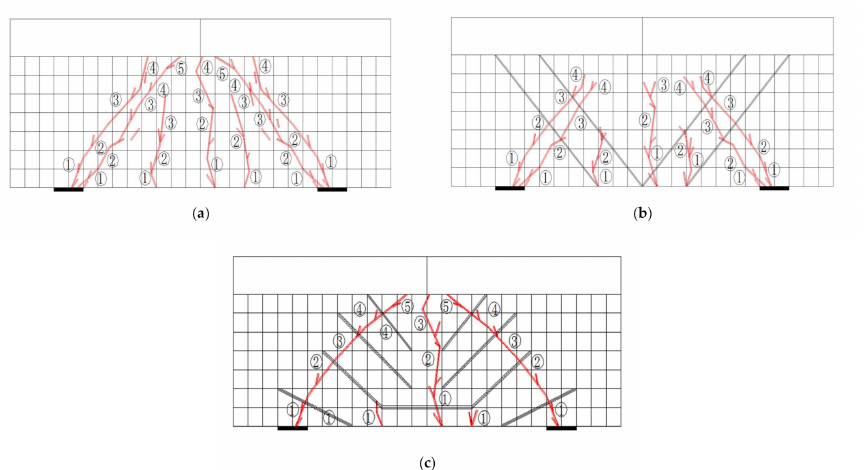
Figure 18. Crack distributions in three-point bending tests: ( a ) Unreinforced beam; ( b ) Scheme I; ( c ) Scheme